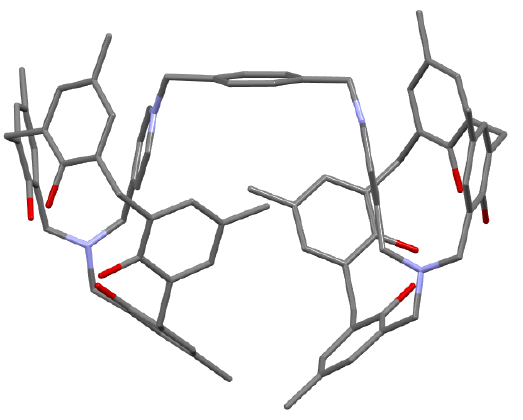
Figure 10. Doubly- and triply-bridged azacalix[3.1.1.1]arenes.